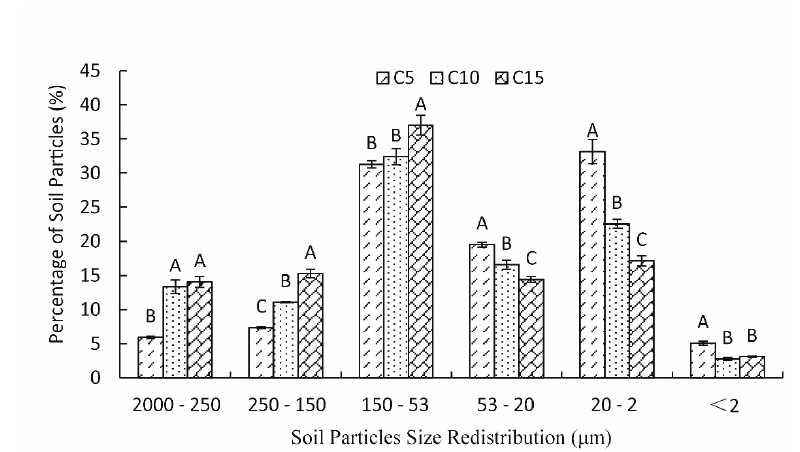
Figure 2. The redistribution of soil particles under different cultivation ages. Different uppercase letters indicate significant differences among the different cultivation ages at p ≤ 0.05. C5 represents the cultivated grasslands with five cultivated years; C10 represents the cultivated grasslands with 10 cultivated years; C15 represents the cultivated grasslands with 15 cultivated years.